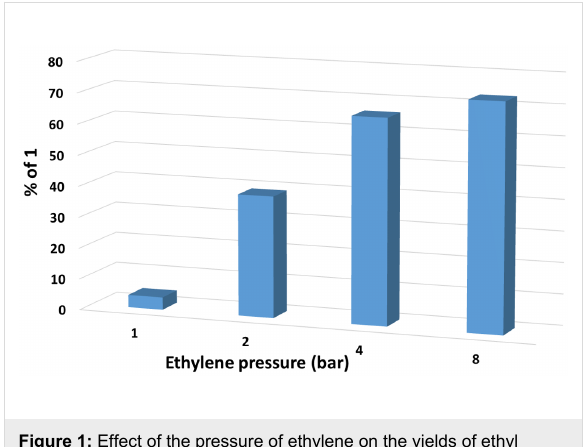
Figure 1: Effect of the pressure of ethylene on the yields of ethyl cyclopropanecarboxylate in the reaction of ethylene and EDA cata- lyzed by IPrAuCl/NaBAr F